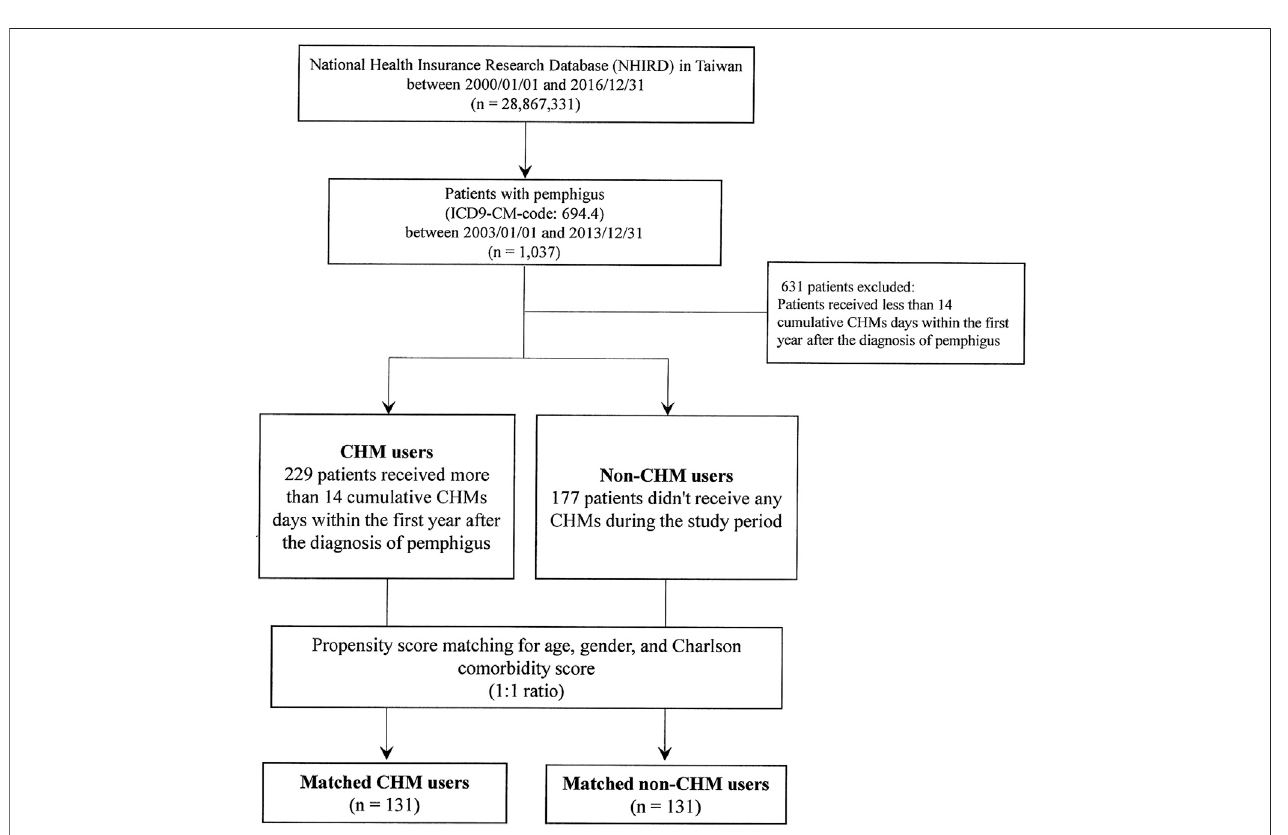
FIGURE 1 | Flowchart for the enrollment of CHM and non-CHM users in patients with pemphigus. Abbreviations: CHM, Chinese herbal medicine.